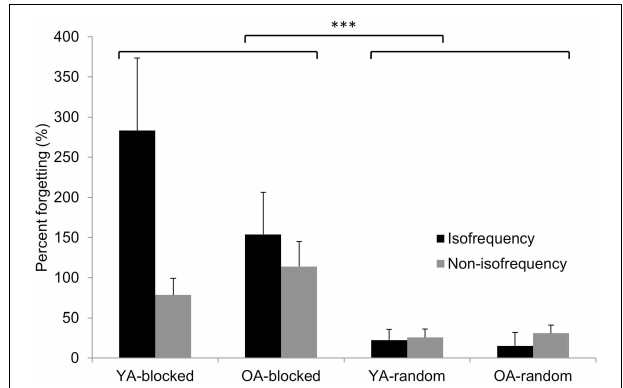
FIGURE 6 | Percentage forgetting score. A percentage forgetting score (% forgetting) was obtained for each subject and was defined as the difference between delayed retention (DR) and the end of acquisition (EoA: TR16) divided by EoA and multiplied by 100. Group means + standard errors are displayed for isofrequency (low complexity task variant) and non-isofrequency (high complexity task variant) ratios. Blocked practice resulted in a higher percentage forgetting score compared to random practice ( *** p < 0 . 001 ). In addition, blocked practice resulted in higher percentage forgetting in the isofrequency compared with the non-isofrequency ratio ( p = 0 . 019 , Tukey HSD) while the percentage forgetting score between these two frequency types was not different after random practice ( p = 0 . 996 , Tukey